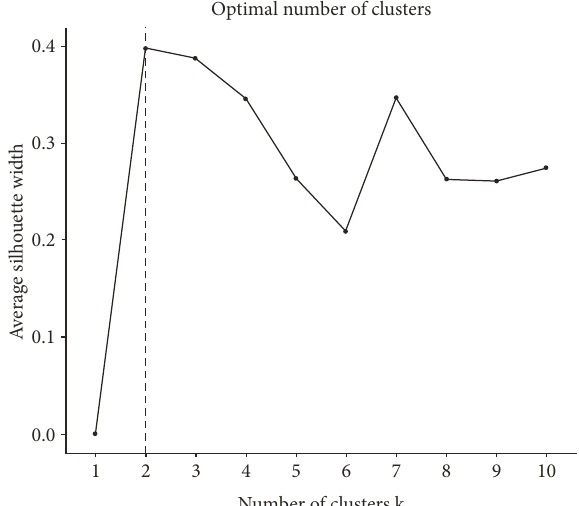
Figure 3: Calculation of the silhouette score in k -means clustering.